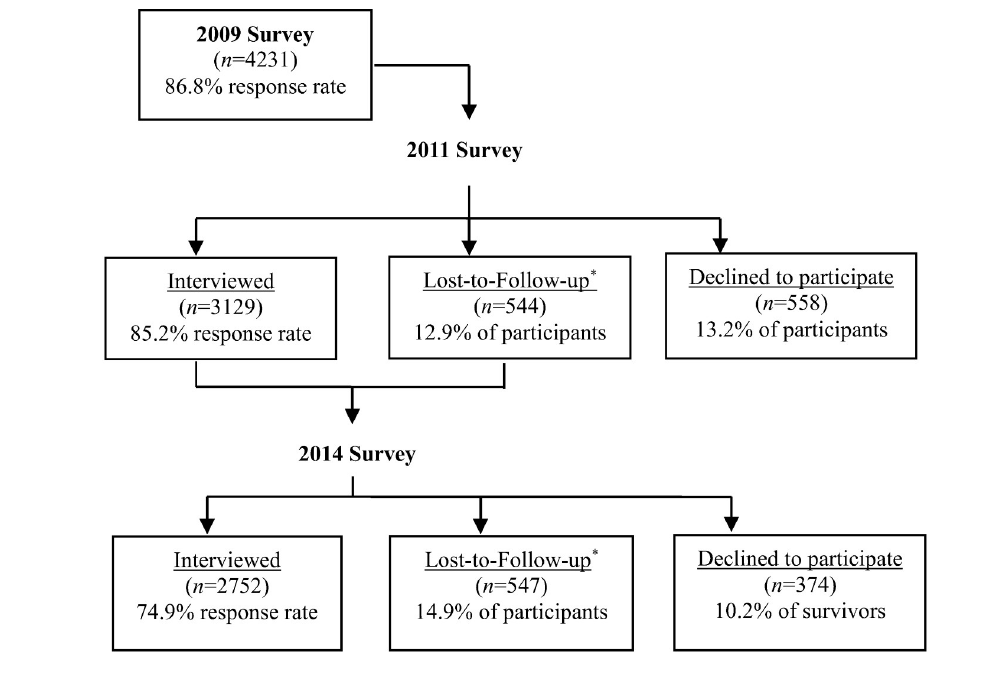
Fig 1. Participants in serial surveys in the Taiwan Youth Project (TYP) from 2009 to